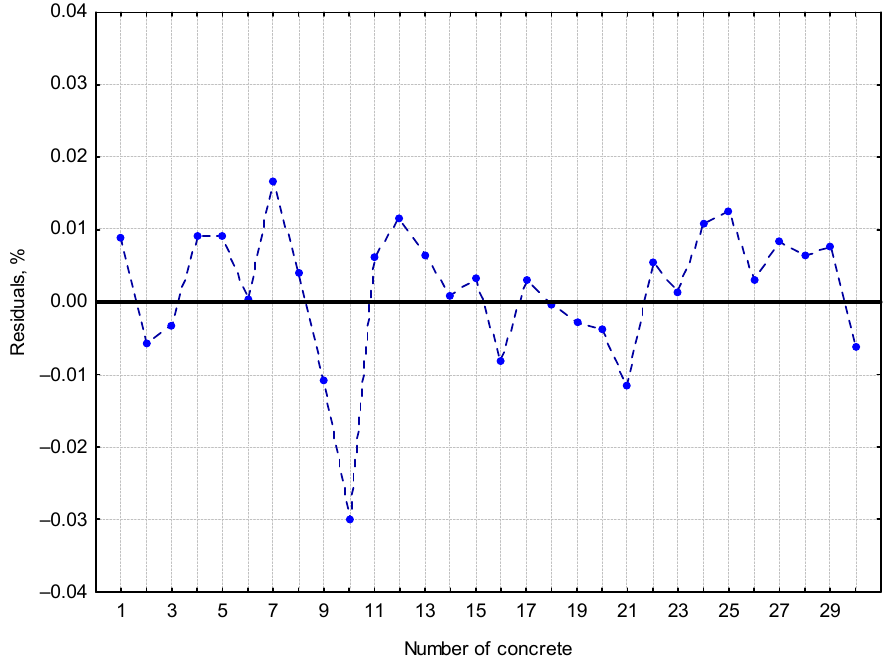
Figure 7. Graph of calculated residuals for 30 concretes.